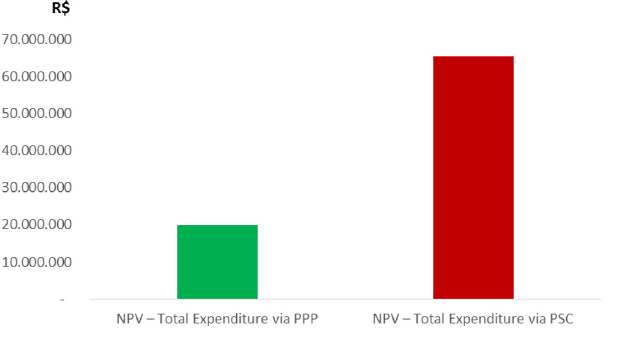
Figure 5. Comparison of